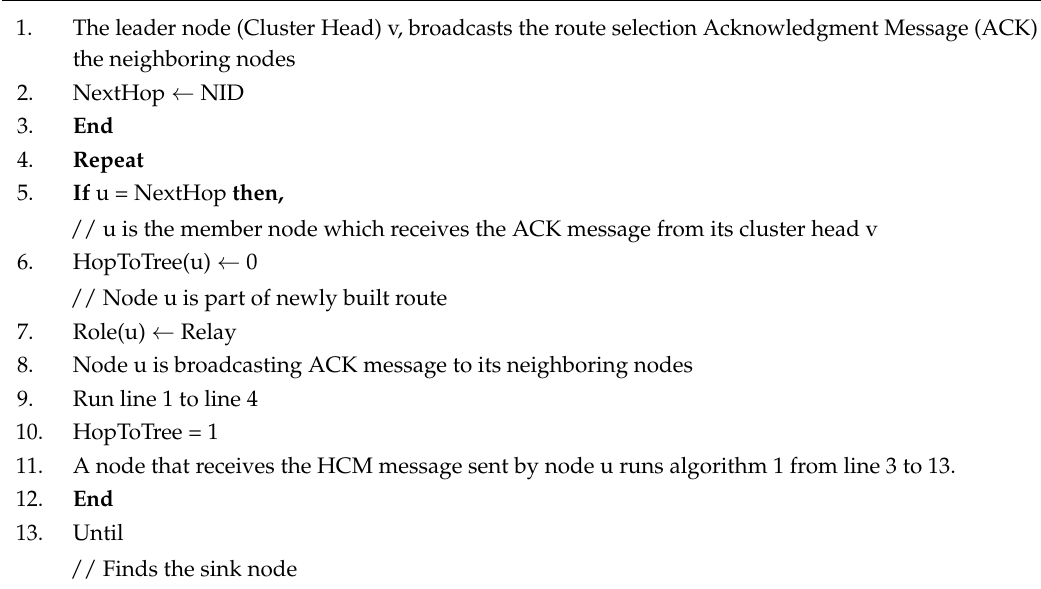
Algorithm 3. Multi-hop routing and Hop Tree